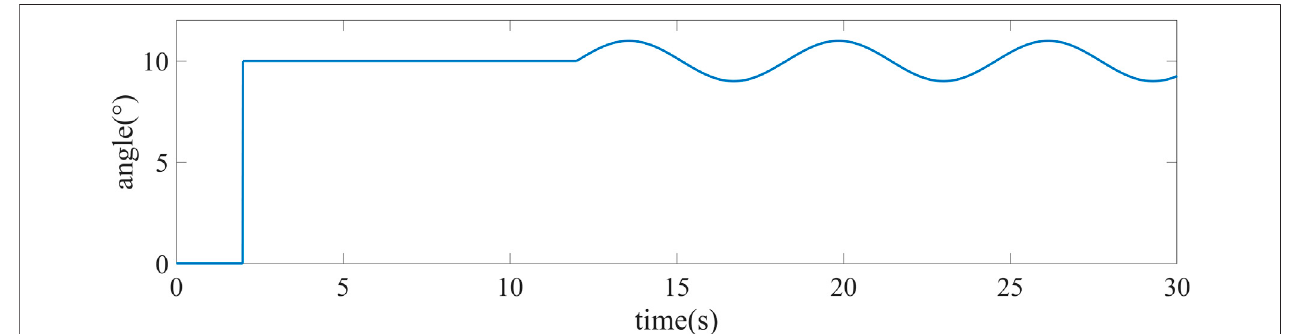
FIGURE 5 | Tracking the target